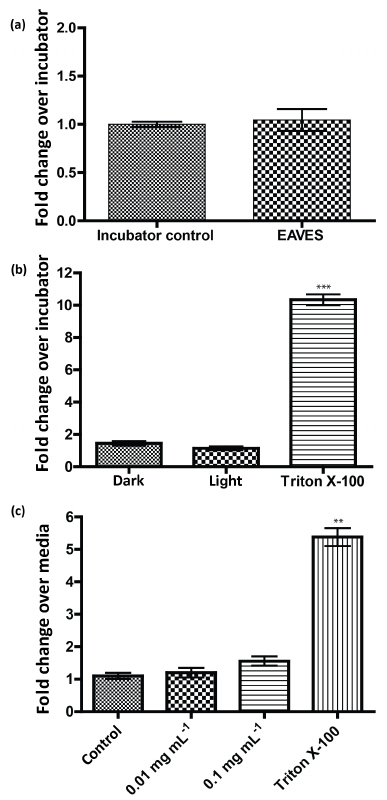
Figure 3. LDH release for (a) clean air controls; (b) EAVES exposures, normalized to incubator control; and (c) resuspension exposures, normalized to KBM-only control. ∗∗ p < 0.005 and ∗∗∗ p < 0.0005.